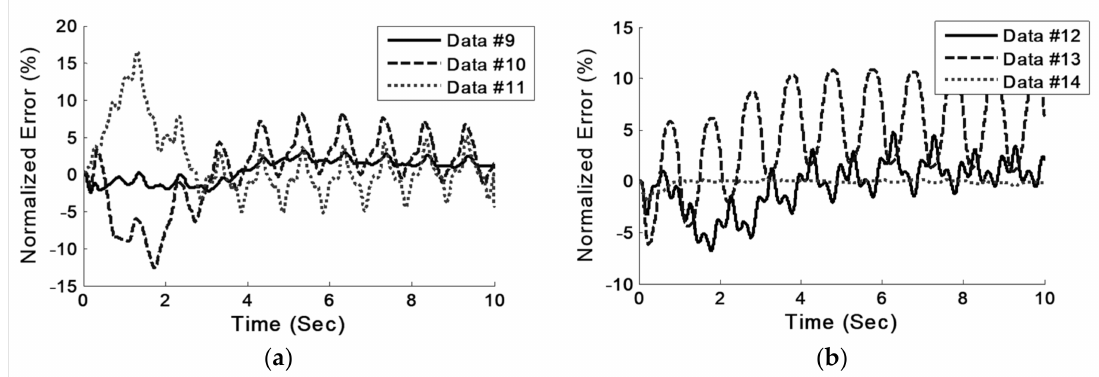
Figure 22. Normalized error of Model 1 in di ff erent tests. ( a ) Tested with Data #4 to Data #6 ( b ) Tested with Data #7 and Data #8.